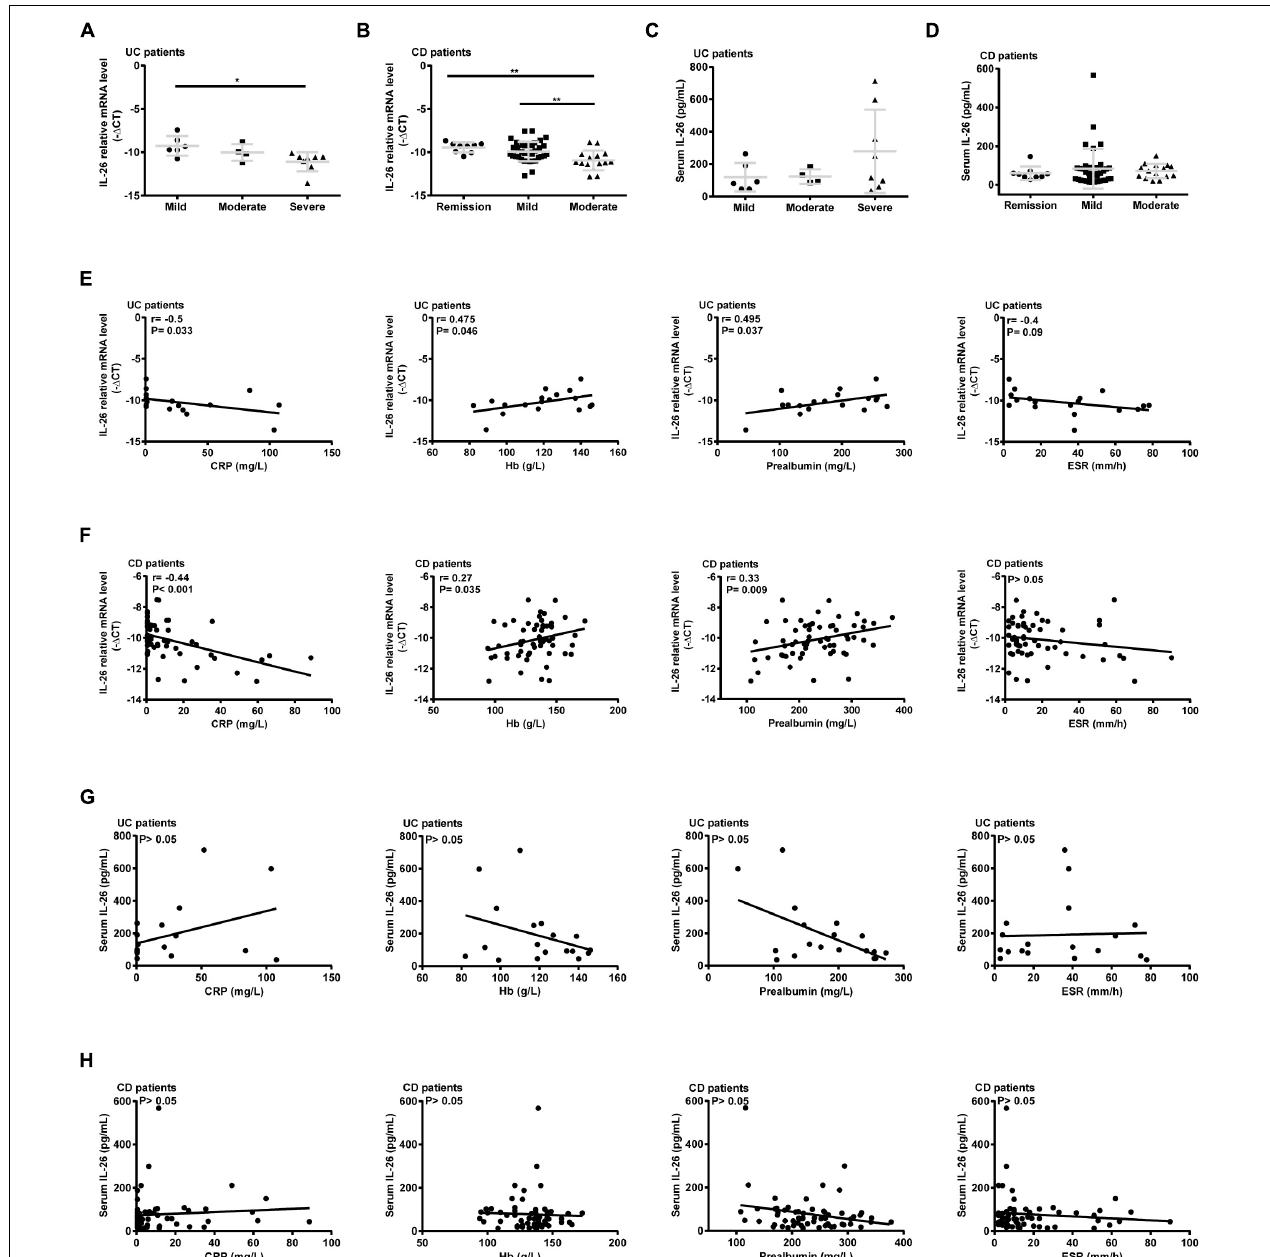
FIGURE 3 | Correlation of IL-26 levels in serum and PBMCs with disease activity in patients with UC and CD. (A,B) IL-26 mRNA levels in PBMCs of UC (A) and CD patients (B) with different disease activity levels. (C,D) Serum IL-26 concentration in UC (C) and CD patients (D) with different disease activity levels. (E,F) Correlation of IL-26 mRNA levels in PBMCs with levels of CRP, hemoglobin (Hb), prealbumin, and ESR in cases of UC (E) and CD (F) . (G,H) Relationship of serum IL-26 levels with levels of CRP, Hb, prealbumin, and ESR in UC (G) and CD (H) patients. * P < 0.05, ** P <